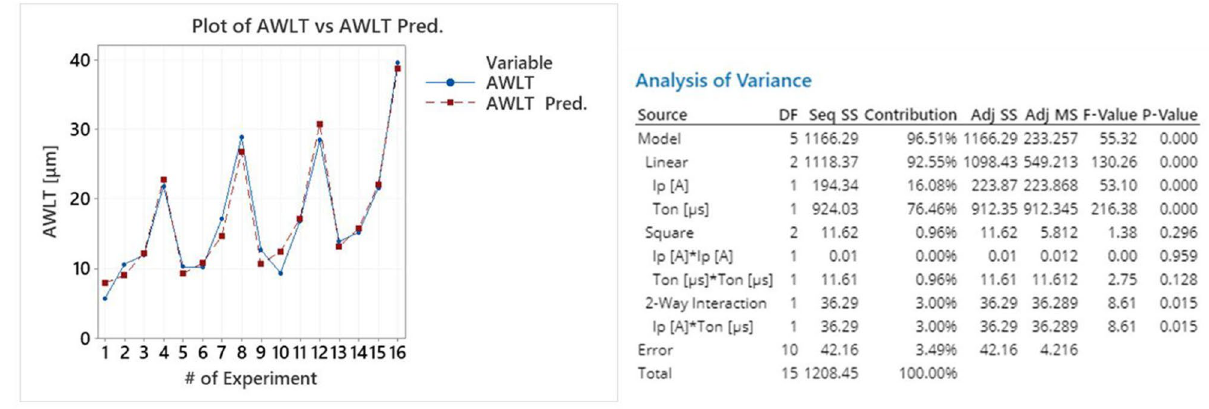
Figure 11. Plot of AWLT vs AWLT predicted and the model’s